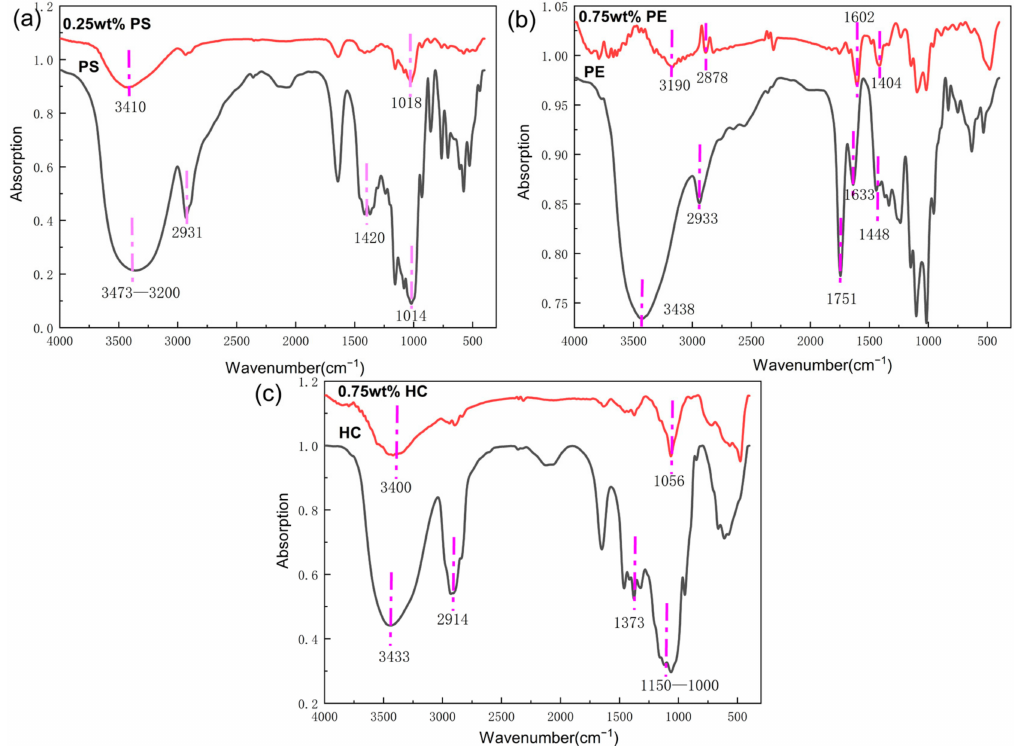
Figure 7. FTIR curves of inerting agent ( a ) PS, ( b ) PE, and ( c ) HC and its reaction products. PE is an acid heteropolysaccharide composed of D-Galacturonic Acids (D-Gal-A) connected by α -1,4-glycosidic bonds. It consists mainly of -OH, C-H, and C-O-C functional groups, as shown in Figure 8c. In Figure 7b, the characteristic peak at 3483 cm − 1 is a typical O-H stretching vibration; that at 2933 cm − 1 is attributed to the C-H stretching vibration of the CH 2 group; the spectral band at 1751 cm − 1 can be attributed to an O-C-O stretching vibration. The PE sample also displays two vibration peak bands at 1380 cm − 1 and 1300–1000 cm − 1 , which are, respectively, caused by the bending of C-H bonds and the stretching of C-O bonds. When 0.75 wt% PE is used, the characteristic peak at 3483 cm − 1 narrows and shifts leftward to 3190 cm − 1 , suggesting that a lot of the OH in PE participated in the adsorption reaction. The characteristic peak at 1751 cm − 1 disappears; those at 1633 cm − 1 and 1448 cm − 1 narrow and shift to the right. FTIR analysis indicated that OH, COOH, and COOCH 3 are the main functional groups in the product that participated in the adsorption reaction. These groups contain one oxygen atom featuring lone pair electrons, which, as the adsorption center, inhibits the hydrogen evolution of Al alloy dust. Similar results have also been reported for PE by other authors